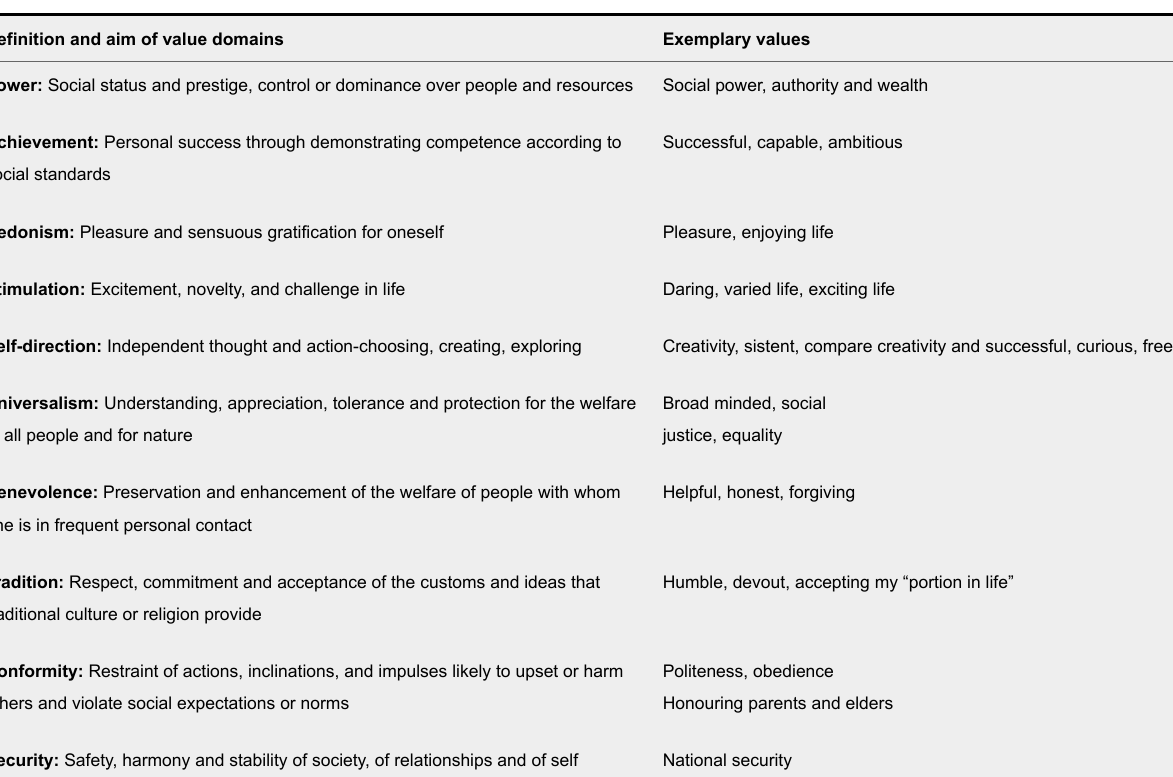
Motivational Domains – Schwartz Value Model (Schwartz, 1994, p. 22) Definition and aim of value